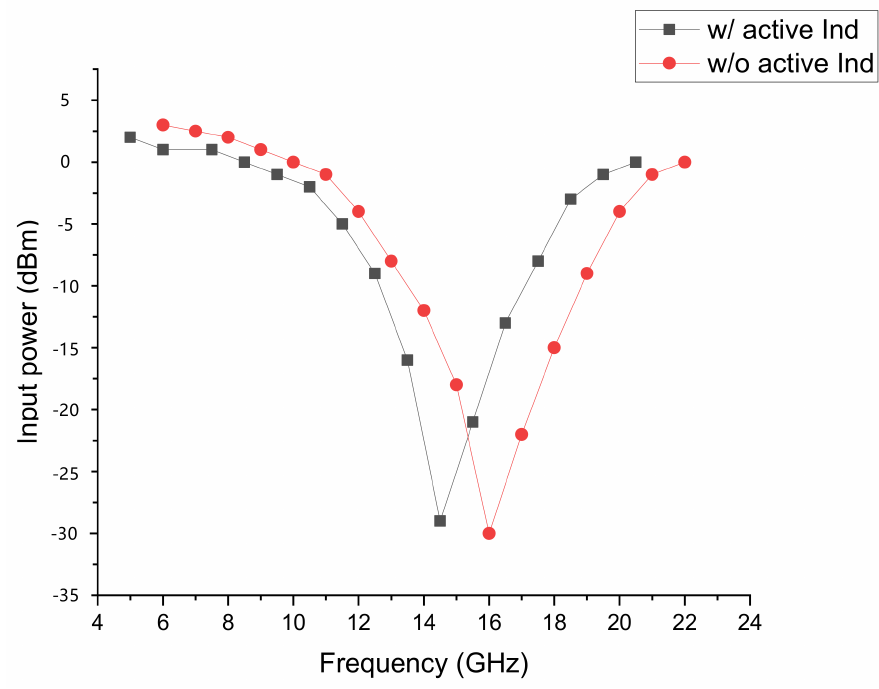
Figure 6. Simulated input sensitivity curves with and without active-inductor-based SCL DFFs.